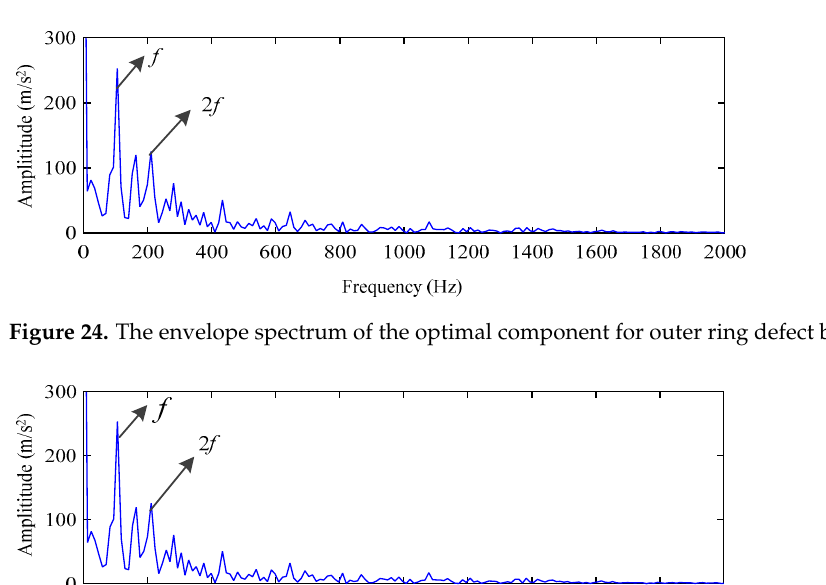
Figure 24. The envelope spectrum of the optimal component for outer ring defect by using EEMD. Figure 25. The envelope spectrum of the optimal component for outer ring defect by using CEEMD.